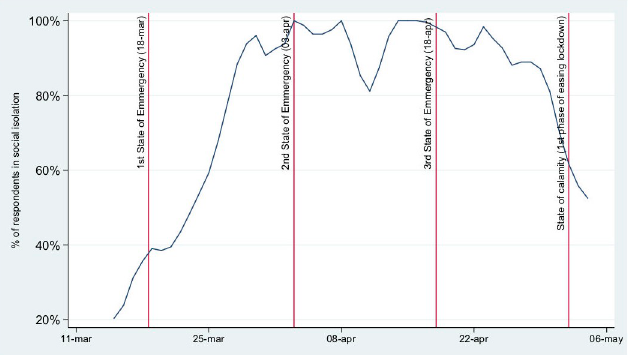
Fig 1. Proportion of respondents with social isolation measures implemented by date (non-cumulative; 3-days moving average). Note: Vertical lines mark the beginning, renewal and end of the state of emergency.